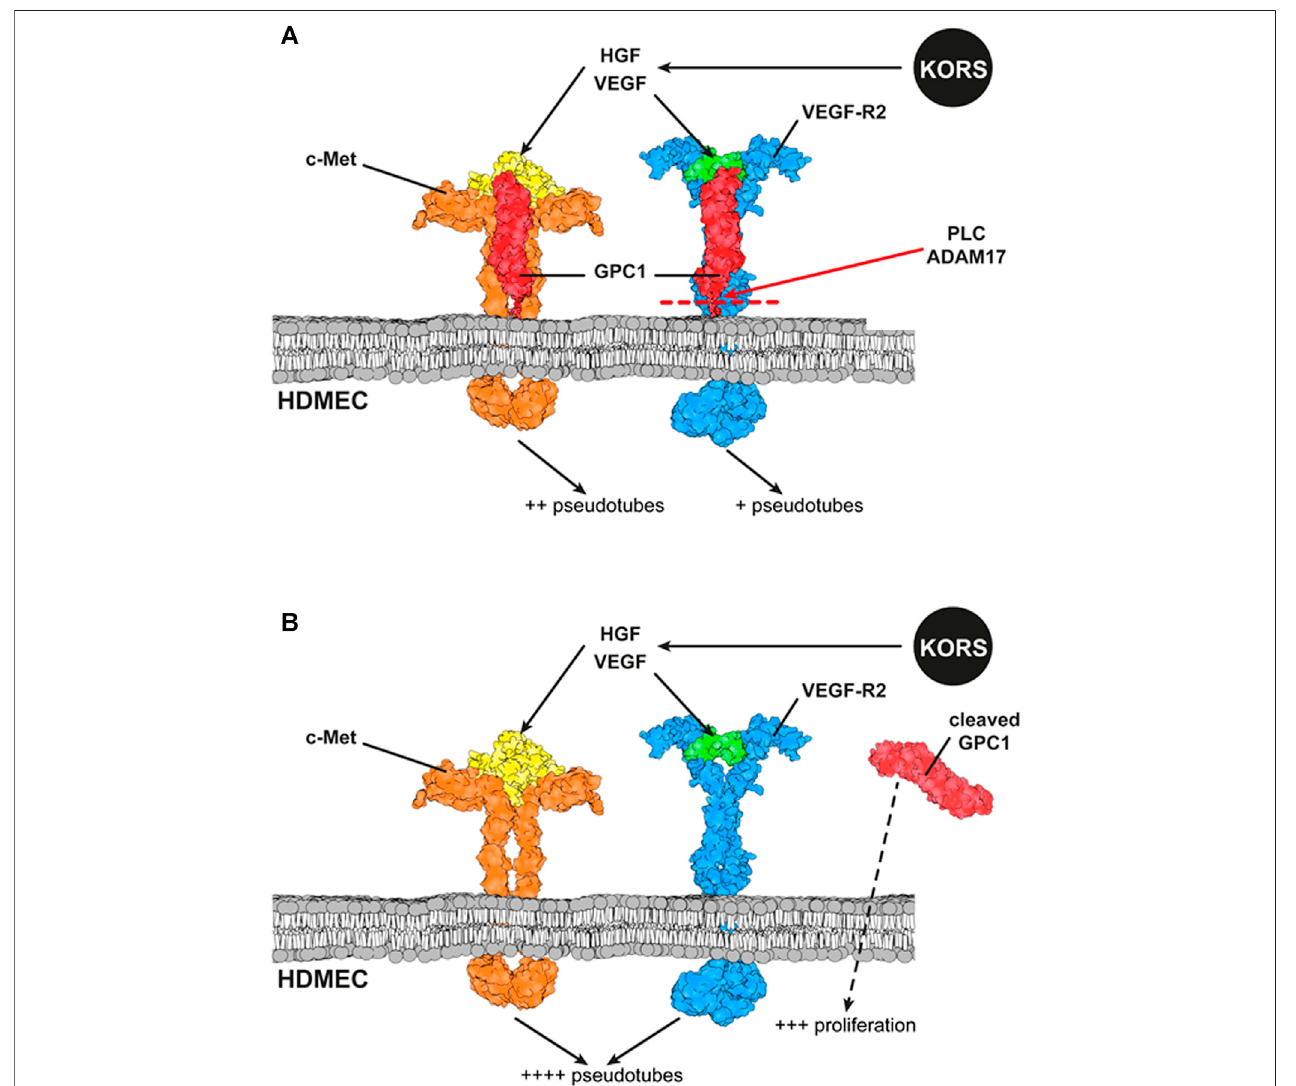
FIGURE10| SchematicrepresentationofinteractionsbetweenGPC1,c-MetandVEGFR2andtheirligandsattheHDMECmembrane. (A) Thedownstreameffect ofthebindingoftheligandssecretedbyKORStotheirspeci fi creceptorsexpressedonHDMECsandtheinteraction betweenthereceptorsareillustrated.Theeffectsof VEGF and HGF on HDMEC pseudotube formation are presented. (B) Effects of GPC1 cleavage by PLC on HDMEC pseudotube formation and proliferation are illustrated.